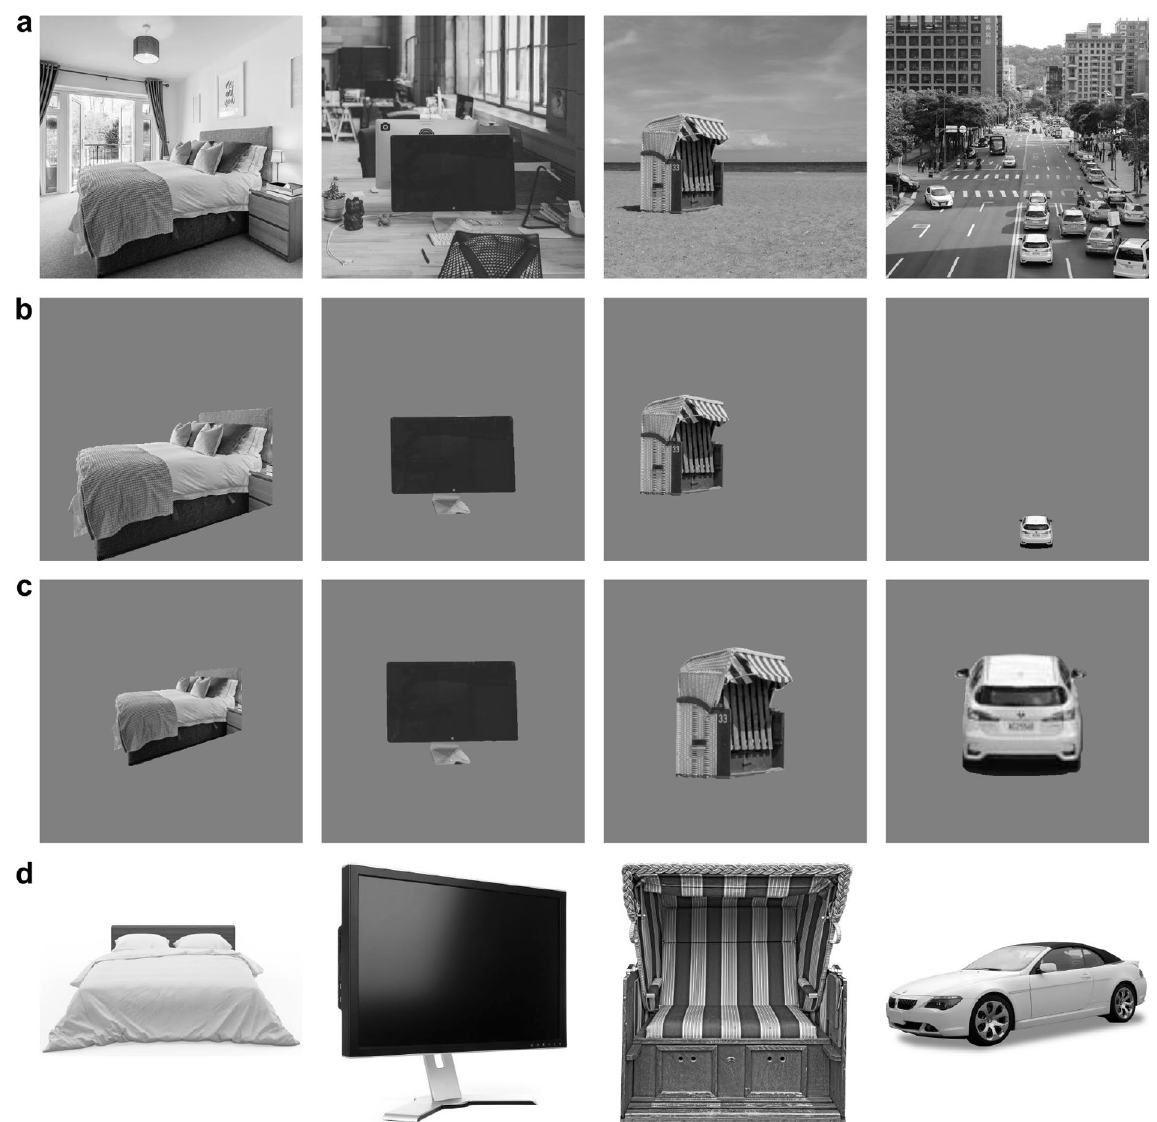
Figure 1. Examples of stimuli used. ( a ) Unprocessed base stimuli (not used in the experiments). ( b ) Stimuli reduced to a single object cut out from the original scenes as used in Experiments 1 and 2. ( c ) Stimuli reduced to a single resized and centred object cut out from the original scenes as used in Experiment 3. ( d ) Stimuli showing a prototypical image of the object as used in Experiment 4. All images from pixabay.com except for bed image in ( d ) by alexandercho,